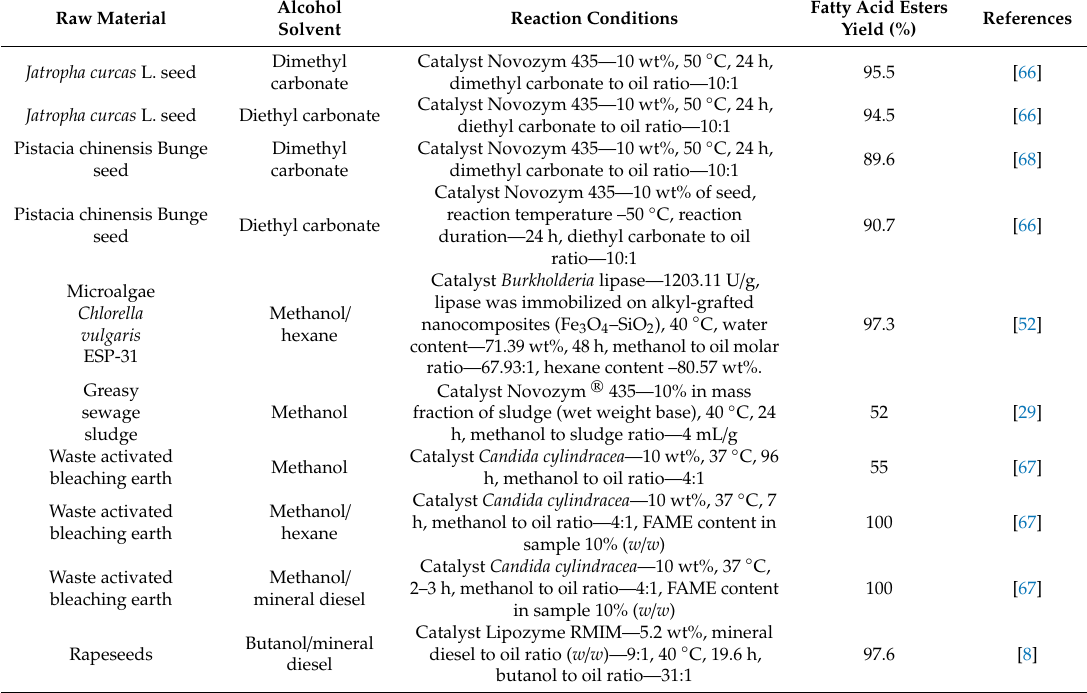
Table 5. Summary of studies on using biocatalyst for in situ